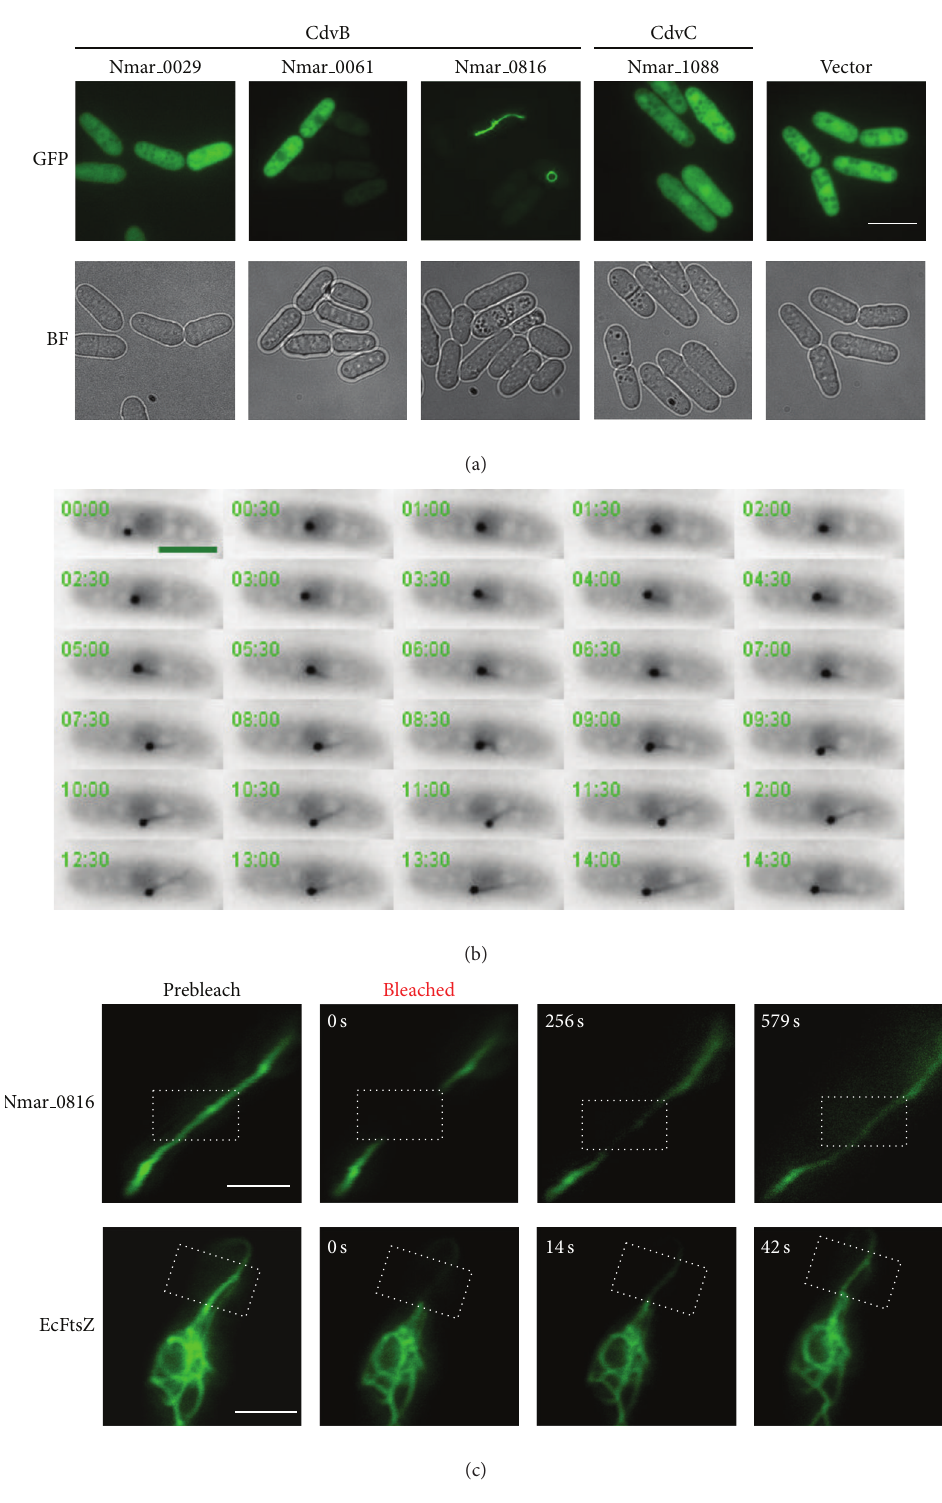
Figure 1: N. maritimus CdvB (Nmar 0816) forms filament-like structures in yeast. (a) Images of fission yeast cells expressing N. maritimus CdvB paralogs and CdvC fused with GFP. BF: bright field; Scale bar: 10 𝜇 m. (b) Time-lapse images of Nmar 0816 polymer formation in fission yeast. Cells carrying pREP42-Nmar 0816-GFP were cultured in the absence of thiamine for 24 h at 24 ∘ C and monitored for GFP signals. Frames were captured at 15s intervals. (Video S1). Scale bar: 5 𝜇 m. (c) Time-lapse images of the Nmar 0816-GFP polymers versus the E. coli FtsZ-GFP polymers upon fluorescence recovery after photobleaching (FRAP). Dotted rectangle indicates bleached region. Scale bar: 3 𝜇